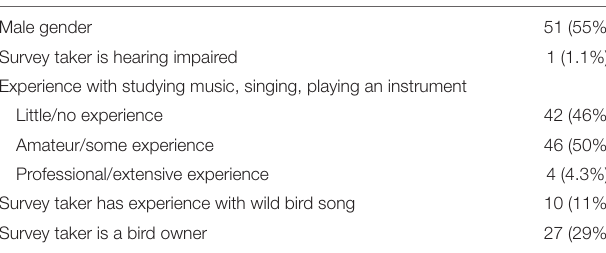
TABLE 2 | Characteristics of survey subjects, N =